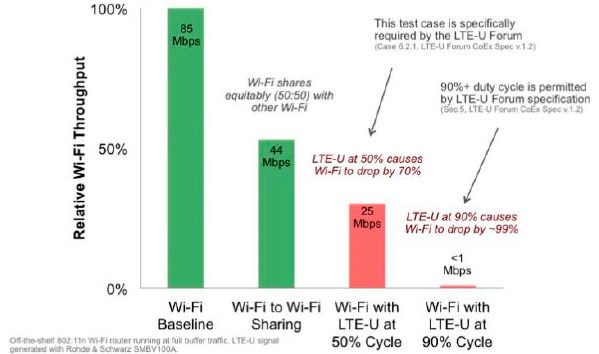
Sensors 2019 , 19 , x FOR PEER REVIEW